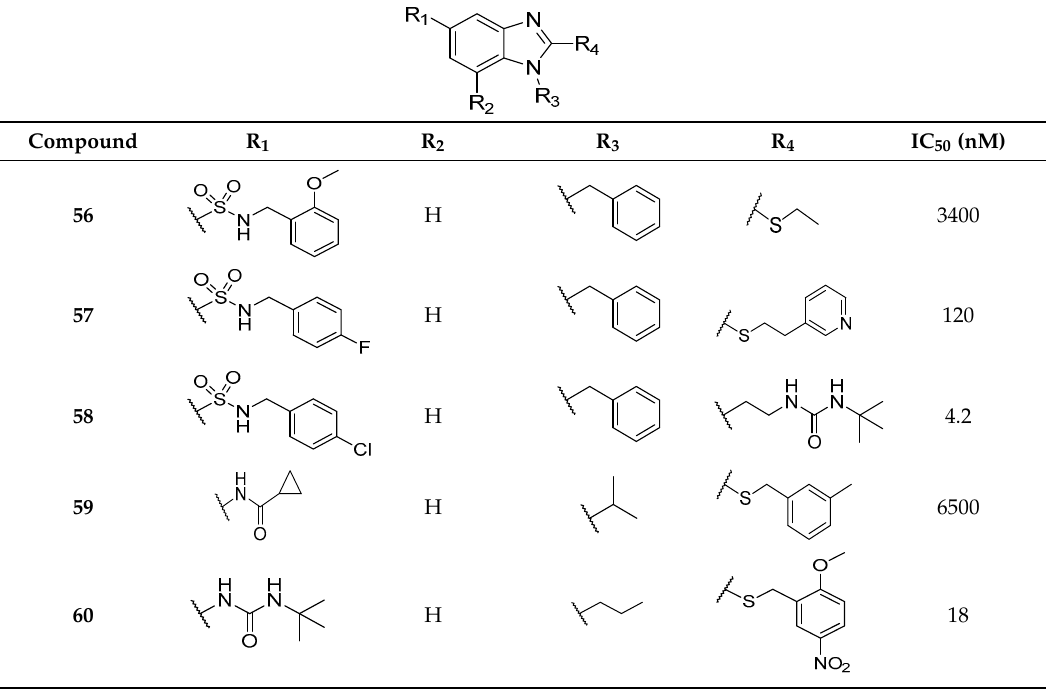
Table 10. Benzimidazole derivatives and their affinity at human GnRH-R.